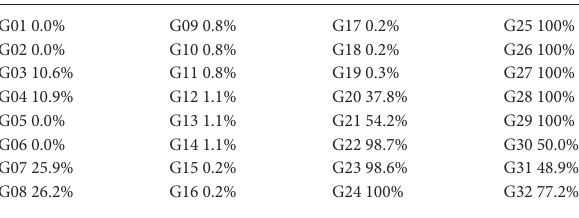
TABLE 1 ON-state ratio of generators in IEEE 24-bus system. G01